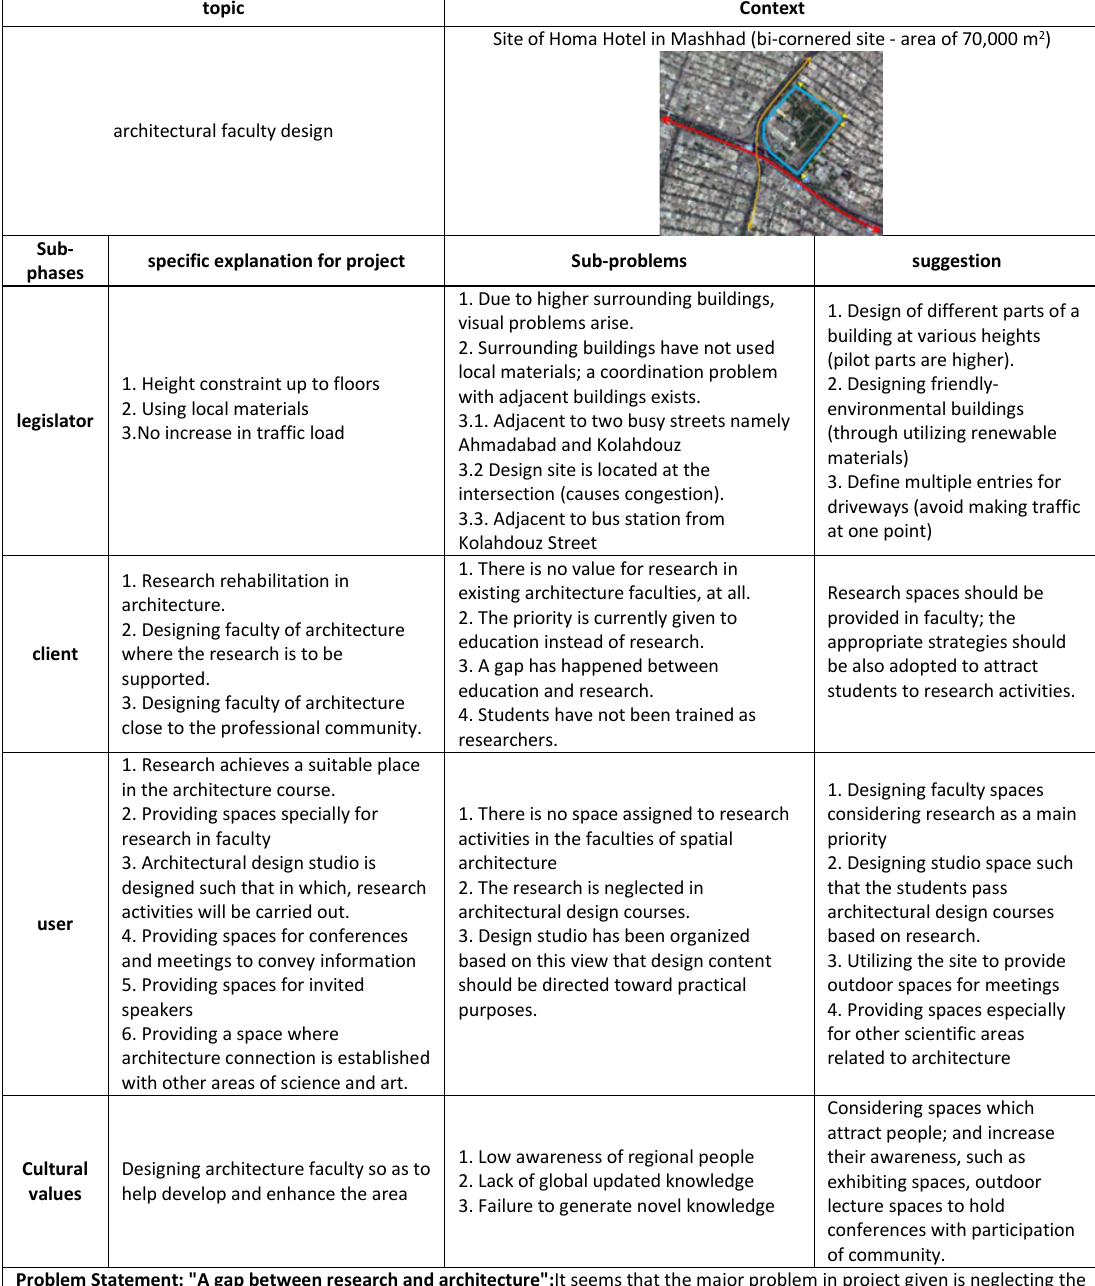
Table 1 Example of problem